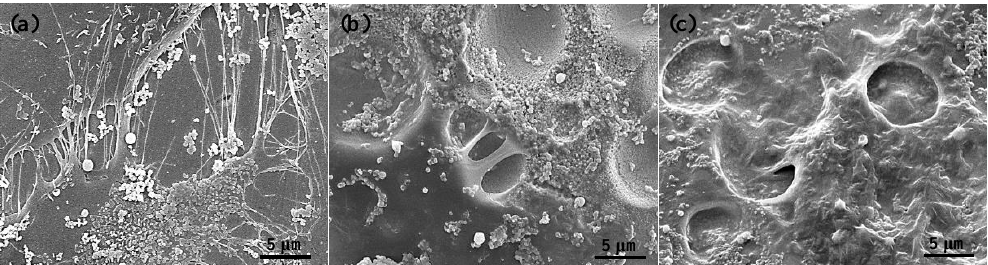
Figure 5. The SEM investigations of osteoblast-like cell (MG-63) morphology on the unmodified 316L BSS specimen and anodized 316L BSS specimens for 24 h incubation: ( a ) unmodified, ( b ) anodized at 5 V for 5 min, and ( c ) anodized at 8 V for 5 min.